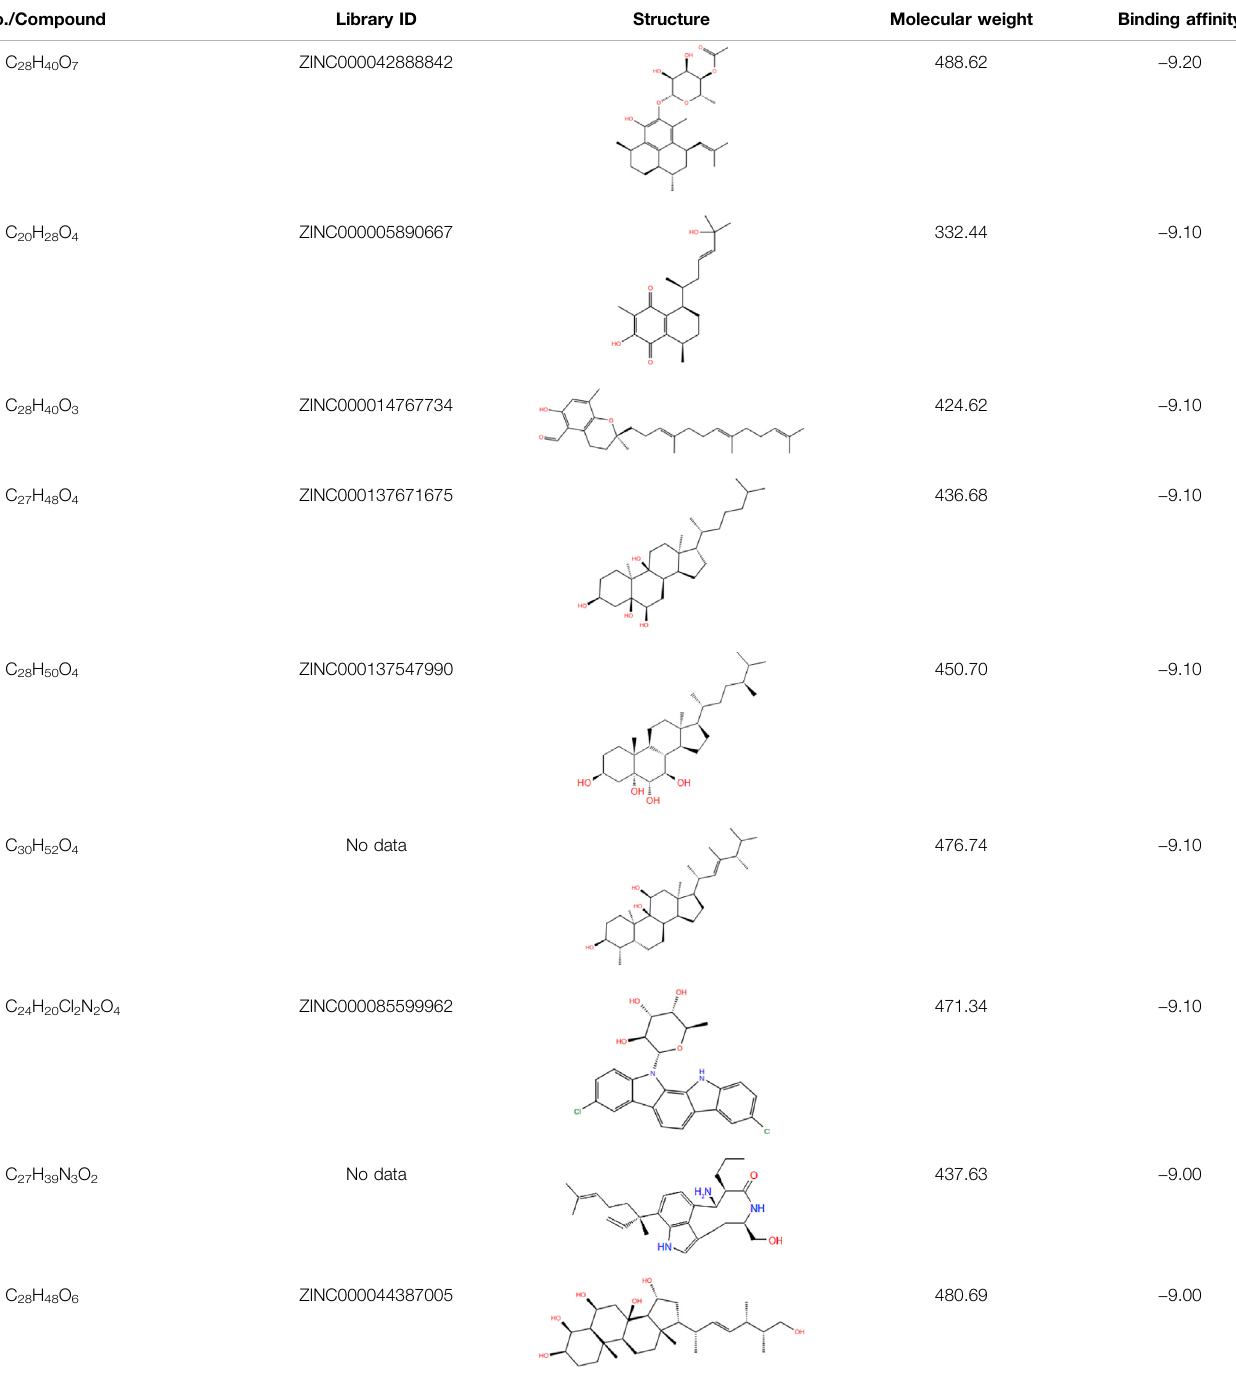
TABLE 1 | ( Continued ) Data collection of potential inhibitors for Fascin by molecular docking. Unit: kcal/mol.